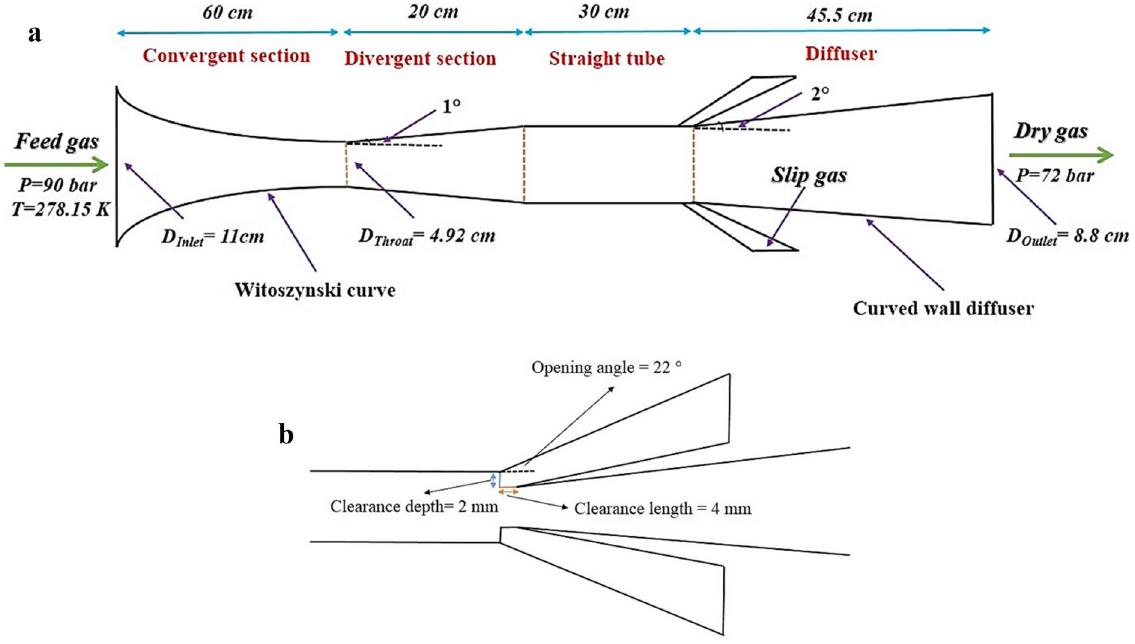
Figure 1. The 2D schematic of ( a ) converging–diverging nozzle, ( b ) drainage